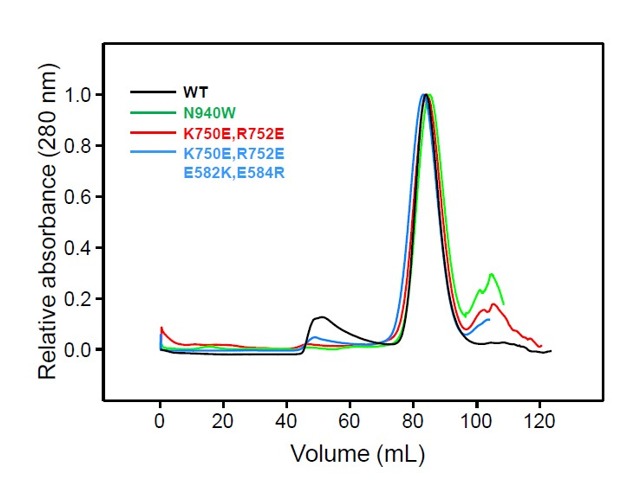
DOI:
http://dx.doi.org/10.7554/eLife.22567.034